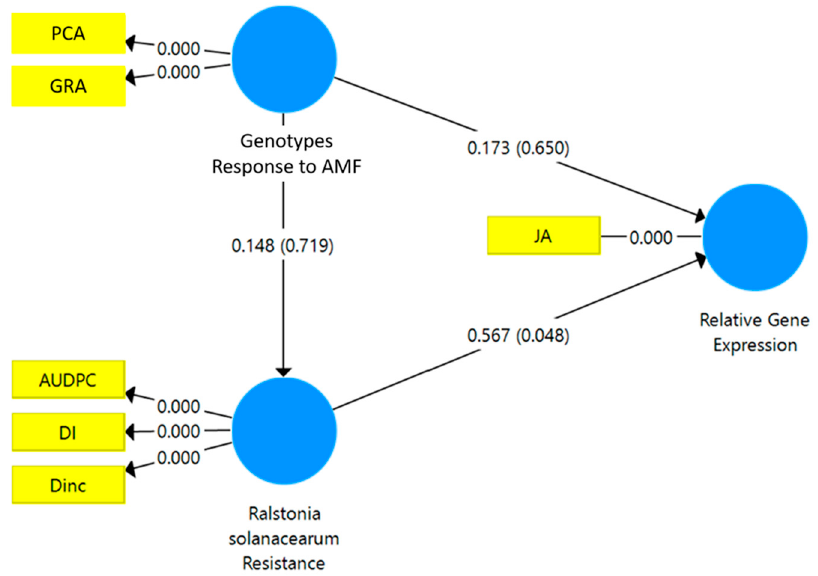
Figure 4. Structural equation modeling-partial least square (SEM-PLS) of the relationship between the responsiveness to mycorrhizae and the resistance of the tropical chili pepper genotypes to the R. solanacearum variables and the relative gene expression of JA. AMF: arbuscular mycorrhizal fungi. PCA: percentage colonization of mycorrhiza, GRA: the growth response of the tropical chili pepper genotype to mycorrhizae, DI: disease intensity, DInc.: disease incidence, AUDPC: area under disease progress curve, JA: jasmonic acid.